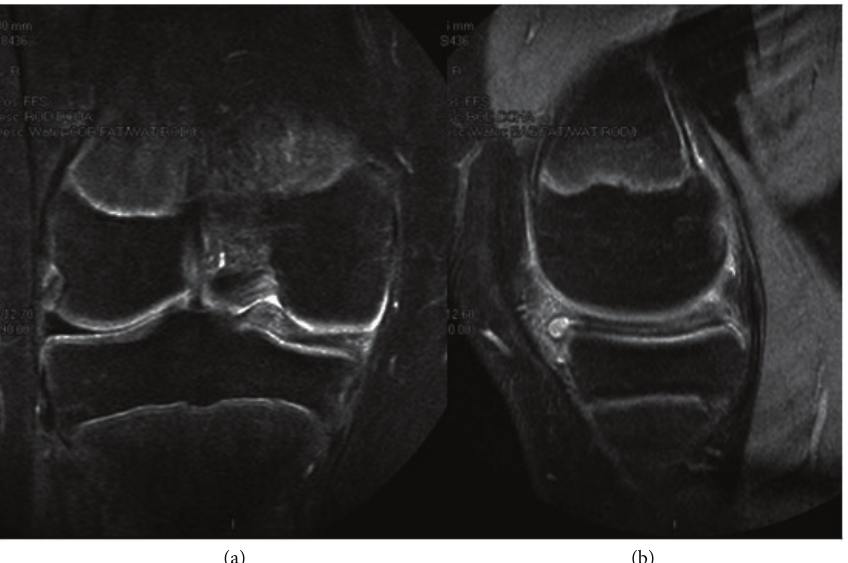
Figure 1: MRI of the right knee. (a) Coronal view showing the upper side of the medial meniscus folded in the intercondylar notch. (b) Sagittal view demonstrating the horizontal tear.